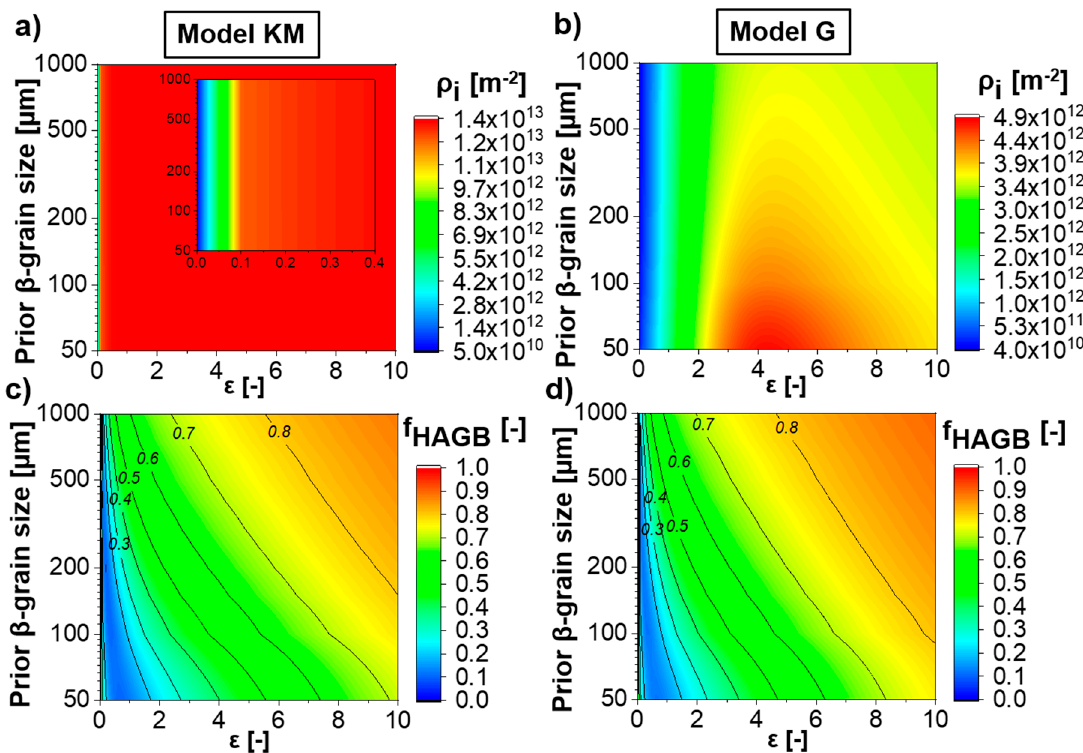
Figure 14. Contour maps of Ti-17 deformed at 830 °C and 0.01 s − 1 showing the influence of the previous β -grain size on ( a , b ) the immobile dislocation density and the ( c , d ) fraction of HAGB, predicted by ( a , c ) “Model KM” and ( b , d ) “Model G”.